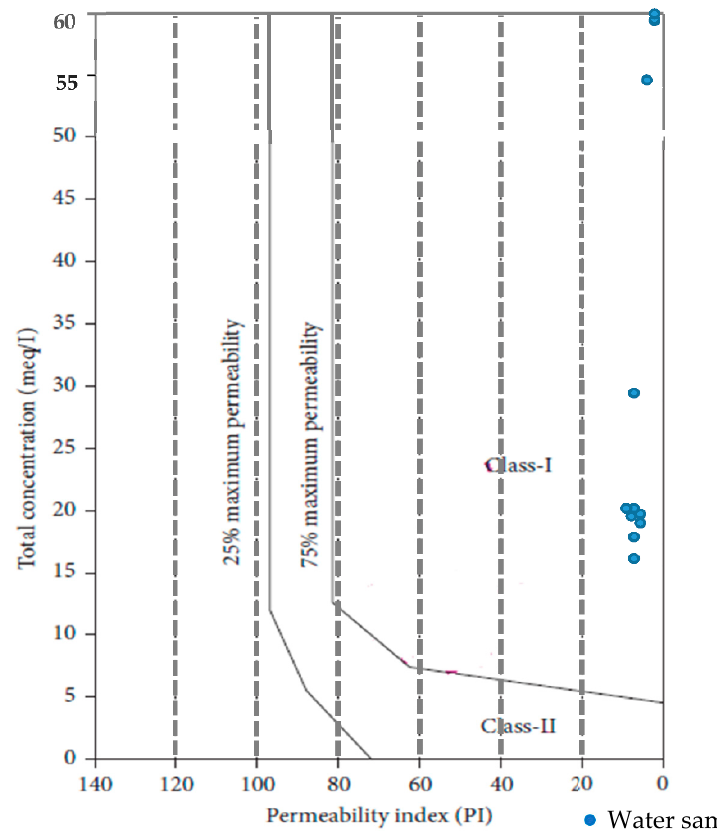
Figure 5. Permeability index diagram classification of groundwater quality .